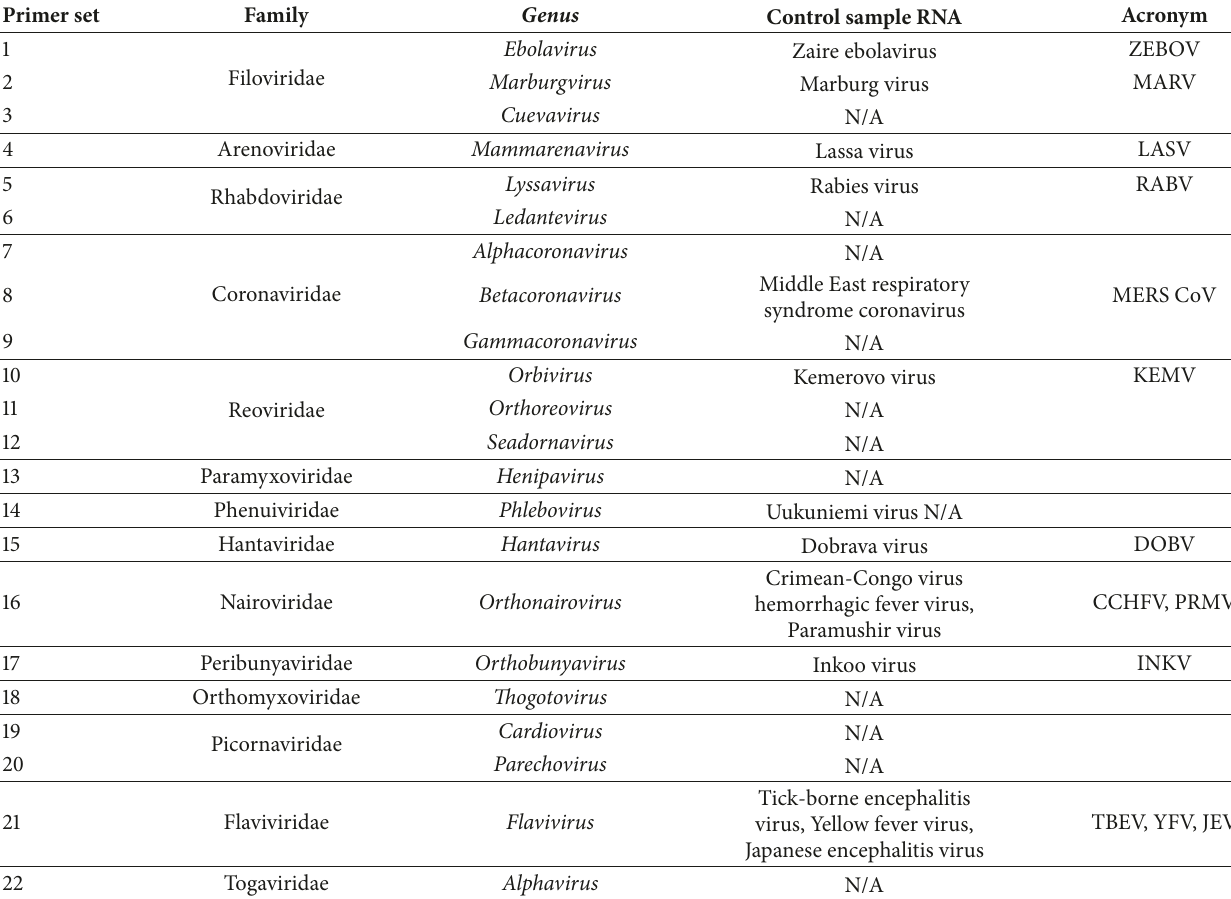
Table 1: Viral families and genera covered by the primer panel and control samples of viral RNA used.